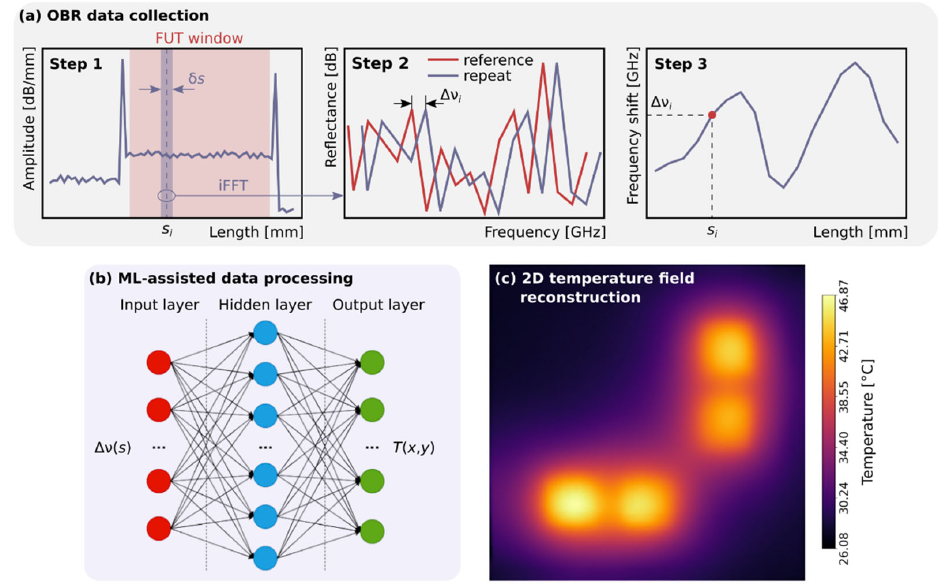
Figure 1. ( a ) Distributed frequency shift measurement for FUT. ( b ) A ML ‐ based model for recalculating the distributed spectral shift Δν (s) into the temperature field T(x, y). ( c ) Reconstructed temperature field.